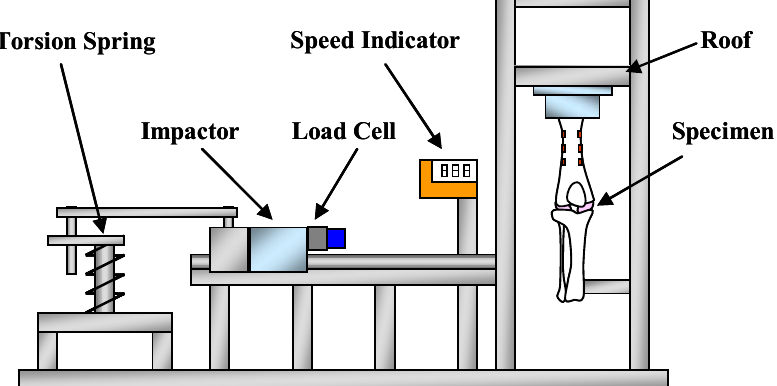
Fig. 1 A schematic diagram of the impact experimental setup. The porcine specimen was fixed under the roof. The impactor, including the load cell, was launched toward the specimen using the energy of the torsion spring and slider-crank